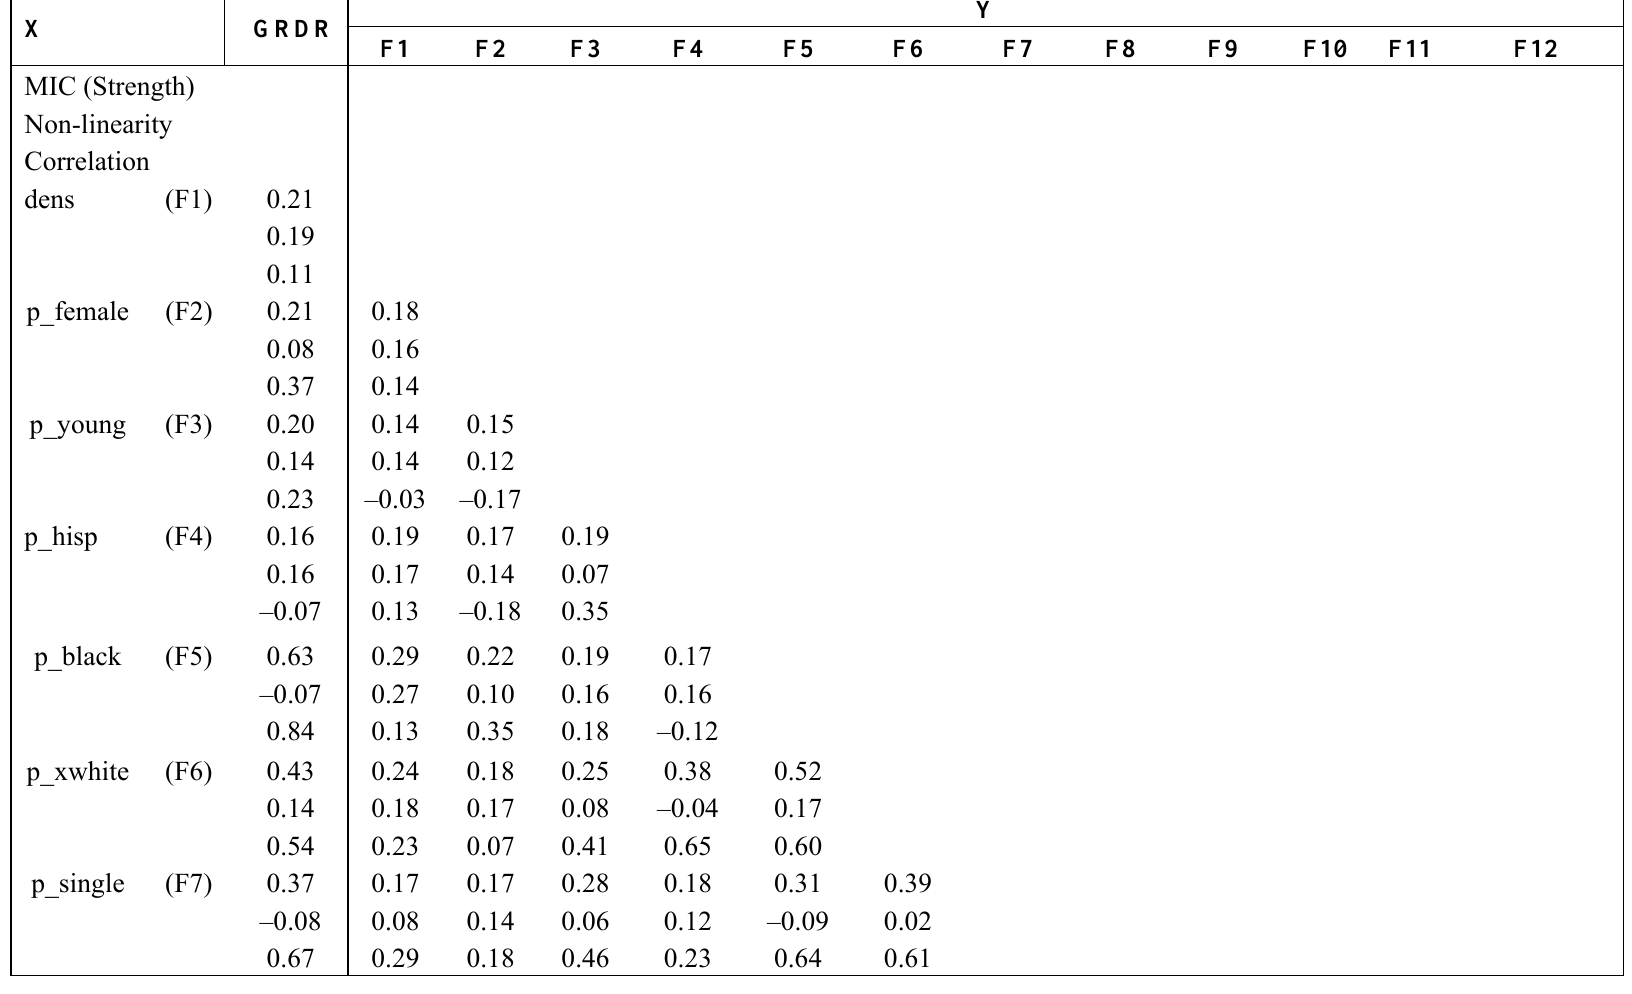
Table 2. Maximal Information Coefficient (MIC) Strength, non-linearity, and correlation between the gonorrhea diagnosis rate (GRDR) and SDH variables and demographic variables: National Notifiable STD Surveillance and American Community Survey data, 2006–2008.